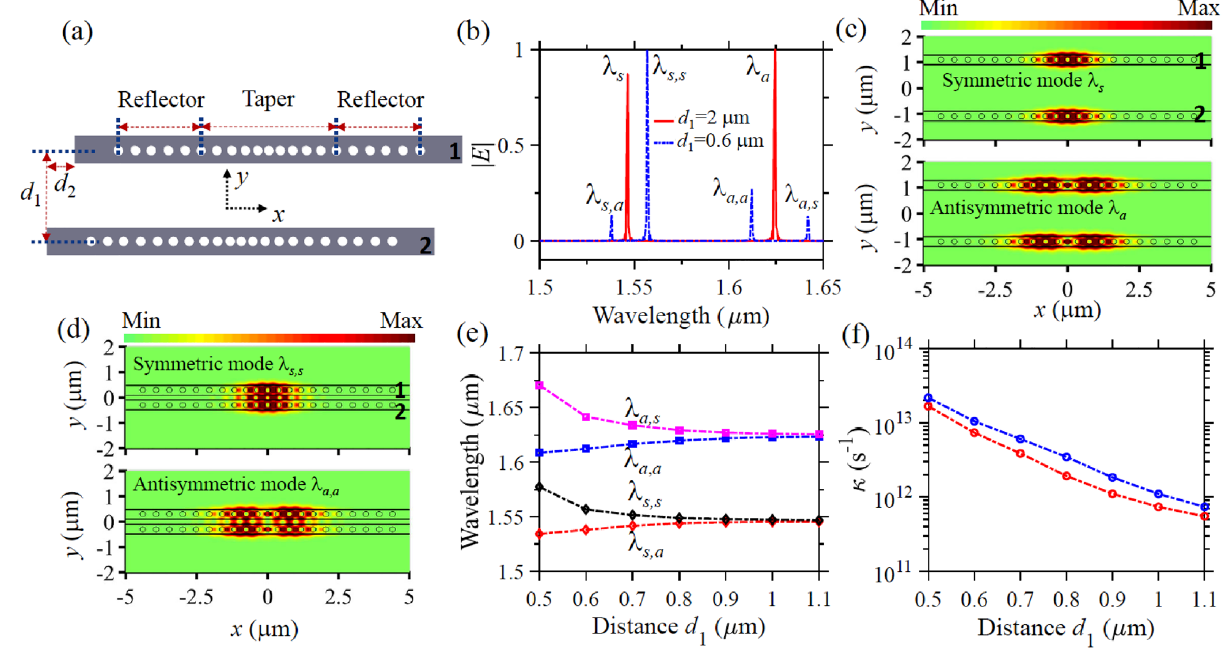
Figure 1. Wavelength splitting characteristics of the resonance modes of the two coupled PhC nanobeams. ( a ) Schematic top view of the two identical nanobeams with transverse spacing d 1 and axial shift d 2 , where each nanobeam consists of a linear array of air holes with the same radius of r in a semiconductor membrane with thickness t and width w . ( b ) The normalized | E | spectra of the nanobeams when d 1 = 2 µ m and d 1 = 0.6 µ m , showing the appearance of the wavelength splitting phenomenon at small d 1 due to strong mode coupling. ( c ) The electric field distribution | E | of the symmetric mode at (cid:31) s = 1.546 µ m and the antisymmetric mode at (cid:31) 1.624 µ m in the plane of the central membrane (i.e., the z = 0 µ m plane) when d 1 = 2 µ m , respectively. a = ( d ) The field distribution | E | of the symmetric mode at (cid:31) s , s = 1.557 µ m and the antisymmetric mode at (cid:31) 1.612 µ m when d 1 = 0.6 µ m , respectively. The field distribution H a , a = z of these modes are given in Figs. S1 and S2 in Supplementary Information. ( e ) Evolution of the four splitting wavelengths (i.e., (cid:31) s , a , (cid:31) s , s , (cid:31) a , a , and (cid:31) a , s ) to the change of d 1 . ( f ) Dependence of the coupling strength κ of the first (red curve) and the second resonance modes (blue curve) on d 1 . In above simulations, each nanobeam has six air holes with hole-to-hole spacing of 0.47 µ m in the reflector sections, and has nine nanoholes in the taper section with the hole-to-hole spacing decreased with a step of 20 nm from either side of the nanobeam to its center. The other geometrical parameters are t = 0.3 µ m , w = 0.4 µ m , r = 0.1 µ m , and d 2 = 0 µ m . The refractive index of the semiconductor membrane is